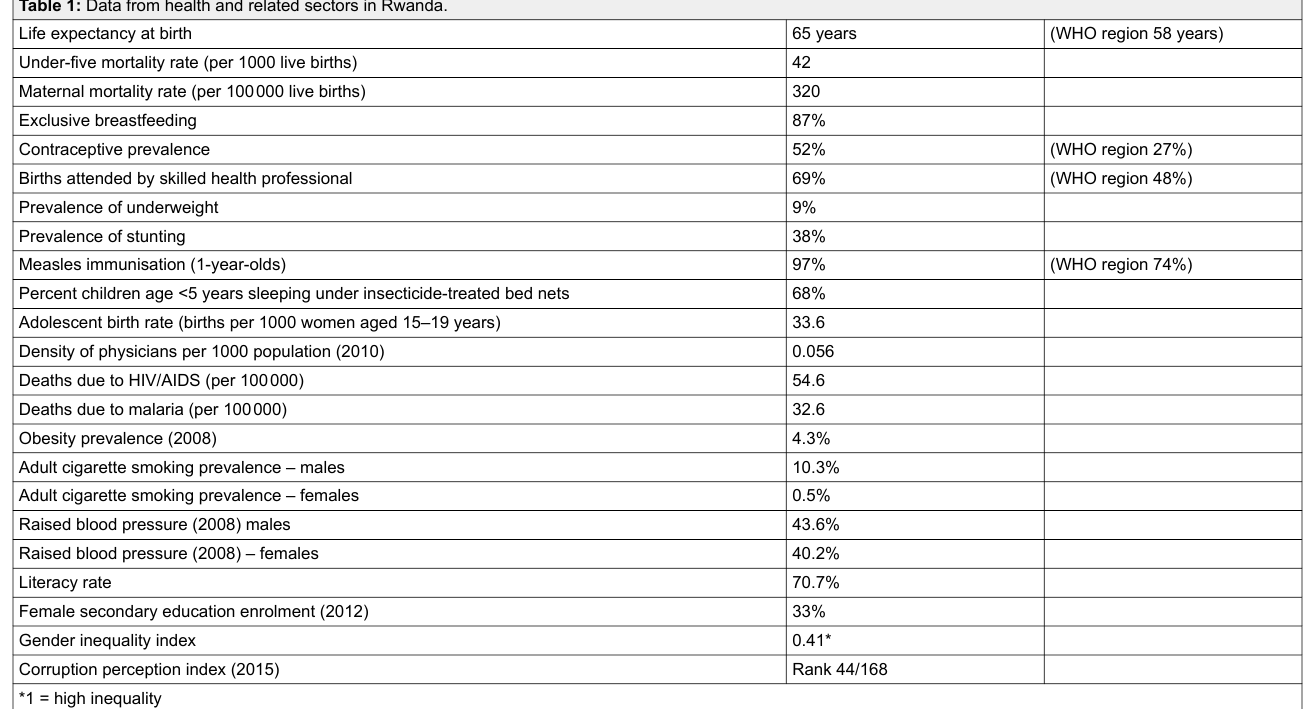
Table 1: Data from health and related sectors in Rwanda. Life expectancy at